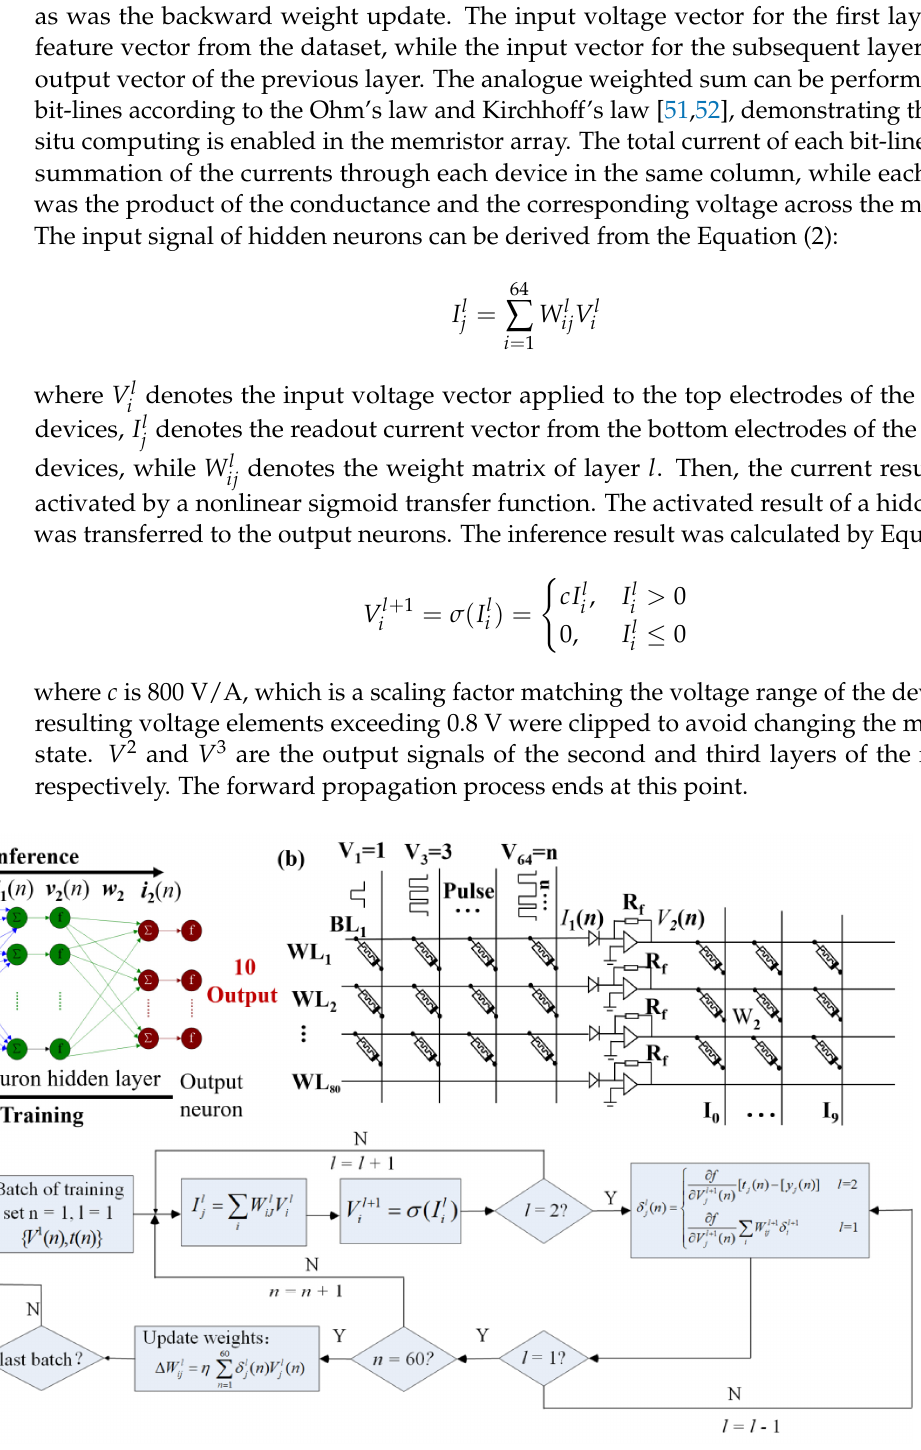
Figure 5. A demonstration of implementation of neuromorphic computing utilizing the proposed device. ( a ) Custom three-layer MLP containing 64 input neurons, 80 hidden neurons, and 10 output neurons. ( b ) Dedicated crossbar array based on the presented memristor for implementing the MLP hardware. ( c ) The training process flowchart of 60,000 images, where l , i , j , and k belong to the range of [1,2], [1,64], [1,80], and [1,10], respectively. These indexes imply the sequence number of the input pixels, hidden neurons, and output results, respectively.